Question: Judging by this figure, is the value going up or going down?
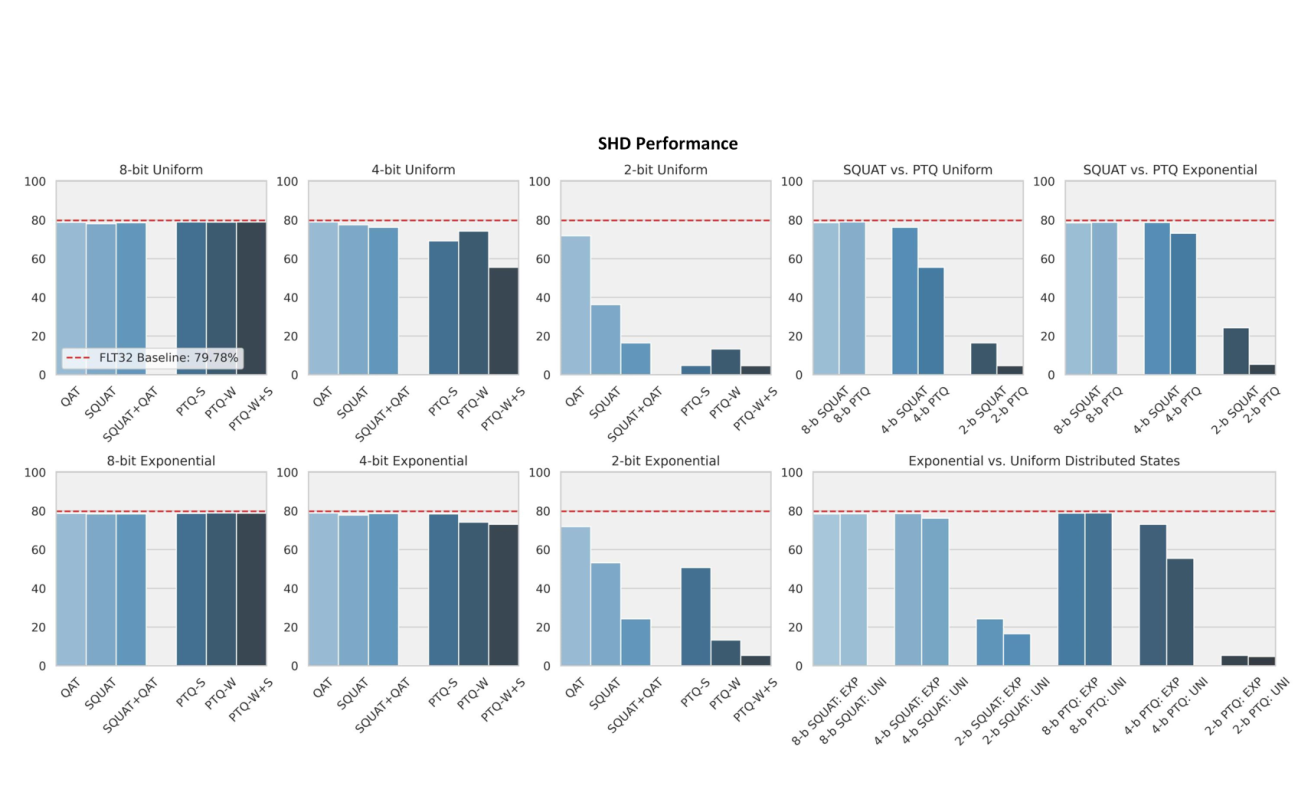
Answer: increasing